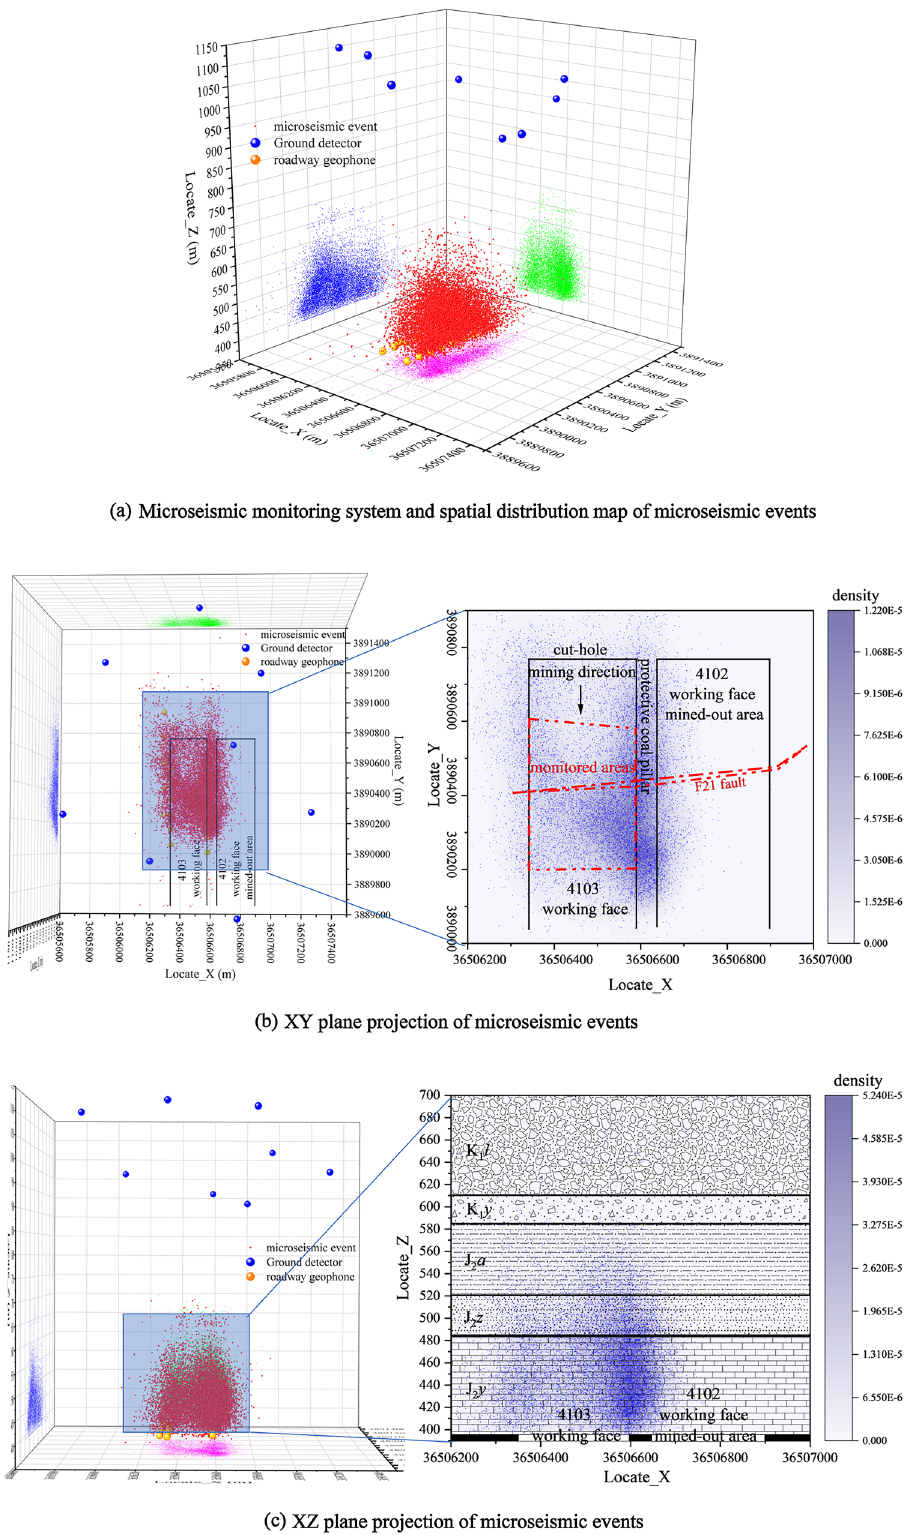
Figure 7. Projection map of the spatial distribution of microseismic